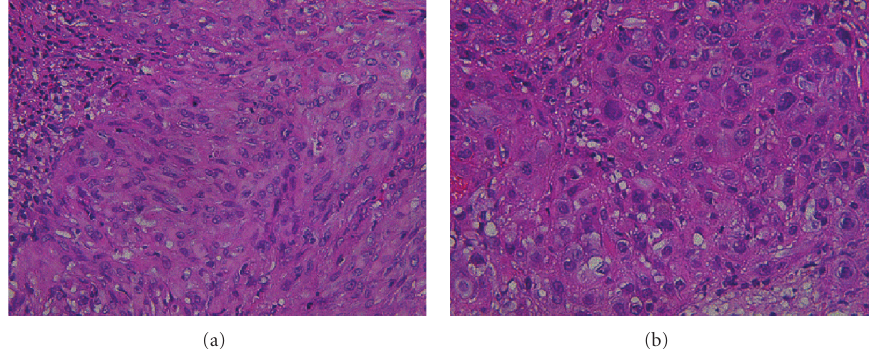
Figure 2: Histological appearance of open biopsy showing that tumor is consisted with malignant (a) spindle and (b) rounded cells with epithelioid